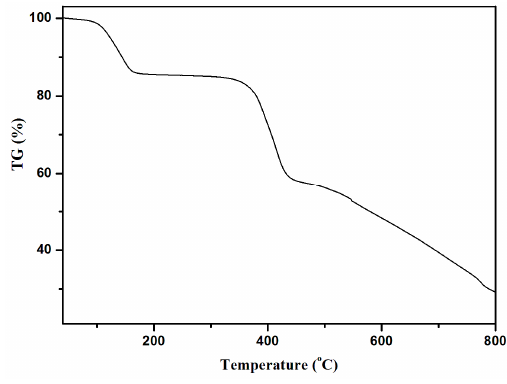
Figure 6. TGA curves for the complex 1 .